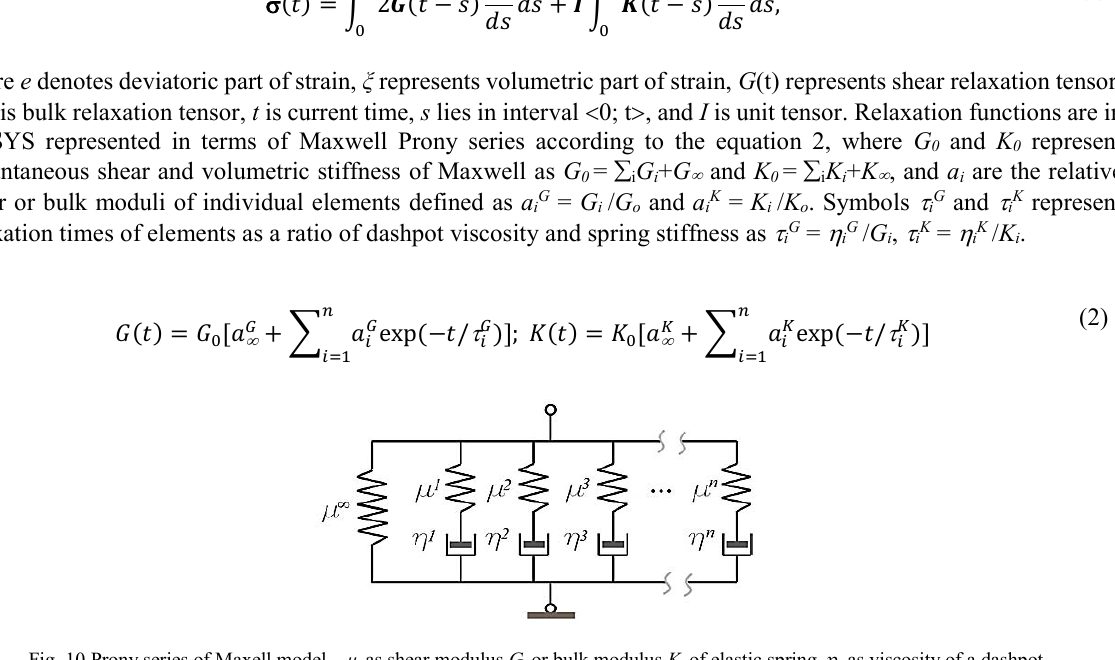
Fig. 10 Prony series of Maxell model – μ i as shear modulus G i or bulk modulus K i of elastic spring,  i as viscosity of a dashpot.